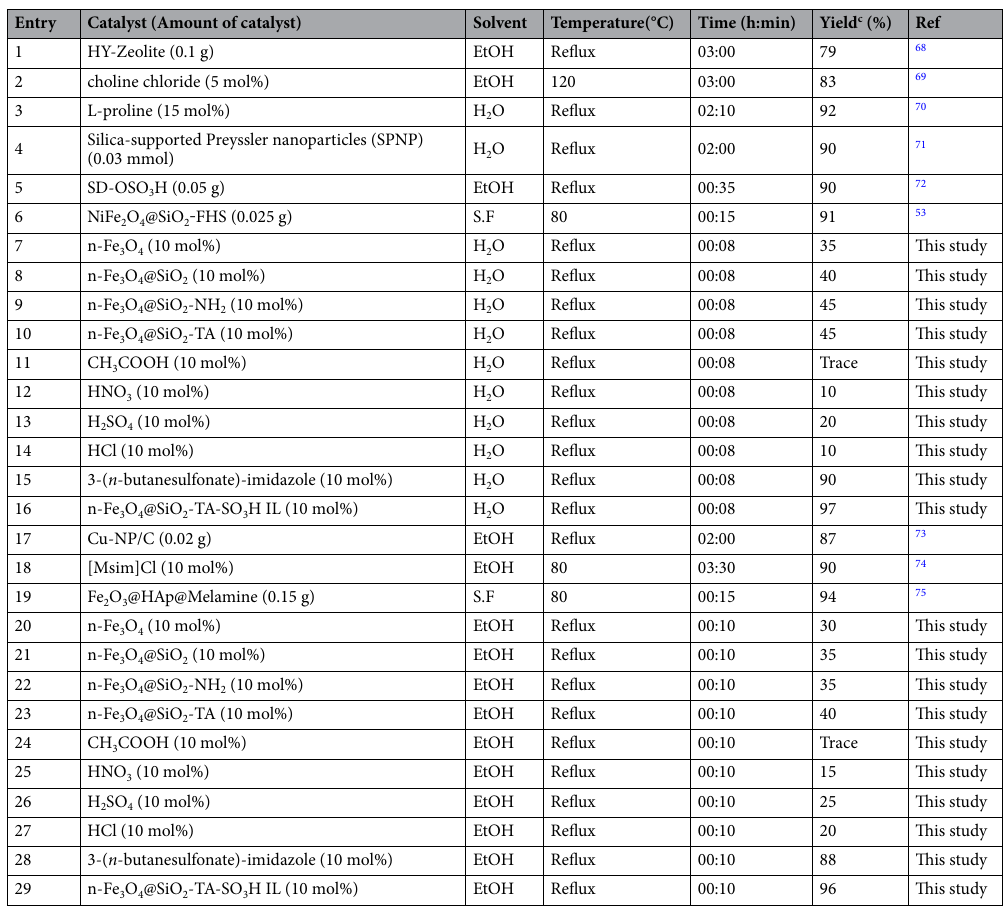
Table 3. Comparison of the efficiency of n-Fe 3 O 4 @SiO 2 -TA-SO 3 H IL with reported catalysts for the preparation of ( 4b ) via symmetric HnR a and ( 6c ) via asymmetric HnR b . a Reaction